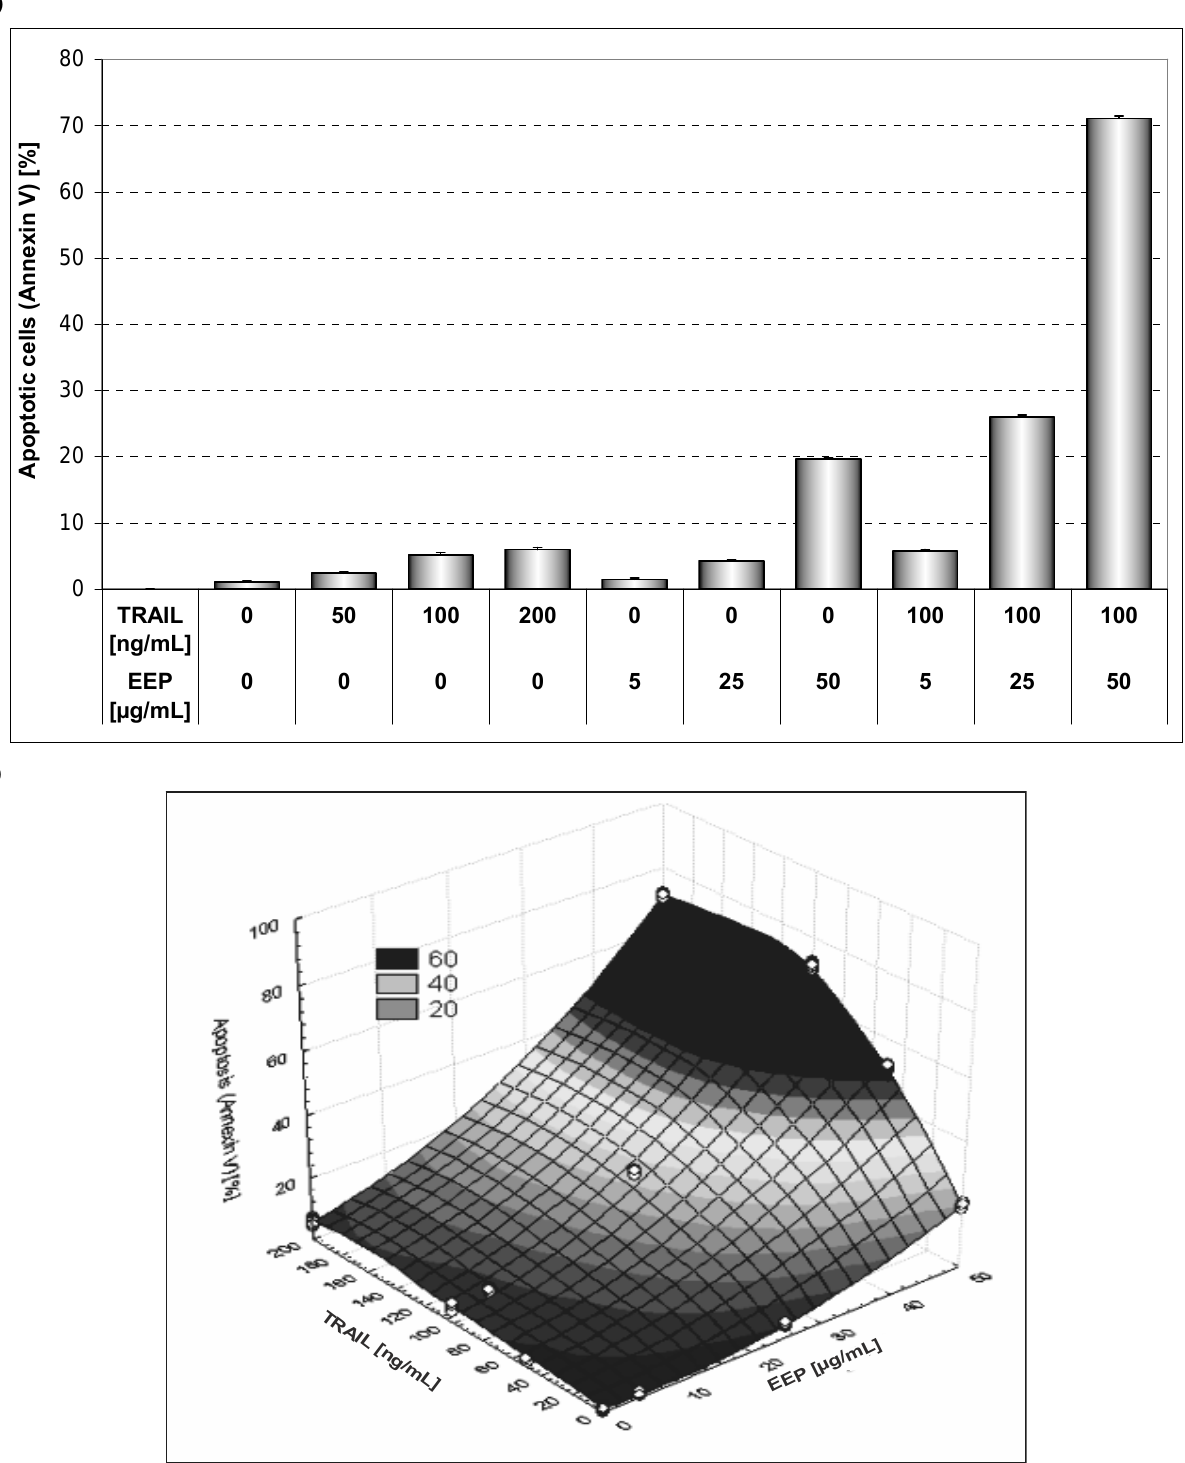
Figure 5. TRAIL induced apoptosis in combination with EEP in HeLa cells. Detection of apoptotic cell death by annexin V-FITC staining using flow cytometry. (A) The cancer cells were incubated for 48 hours with TRAIL at the concentration of 50 – 200 ng/mL and EEP at the concentration of 5 – 50 μ g/mL and the cancer cells were incubated for 48 hours with TRAIL at the concentration of 100 ng/mL and EEP at the concentration of 5 – 50 μ g/mL. (B) The same data was presented in 3-D